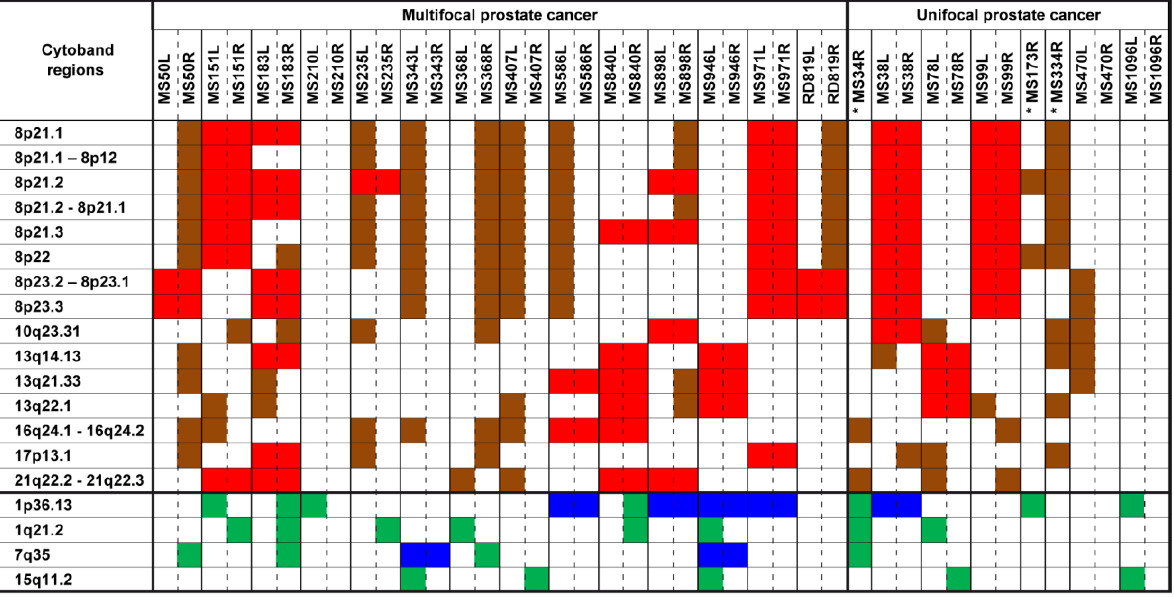
Figure 1. Most frequent copy number alterations in 41 tumor foci from 22 patients. (Color representations: red indicates losses observed in both tumor samples from a single prostate; brown indicates losses in one out of two tumor samples from a single prostate; blue indicates gains in both tumor samples from a single prostate; green indicates gains in one out of two tumor samples from a single prostate). (*) Matching left samples from these cases: MS34, MS173 and MS334 were not investigated, due to insufficient tumor quantity.